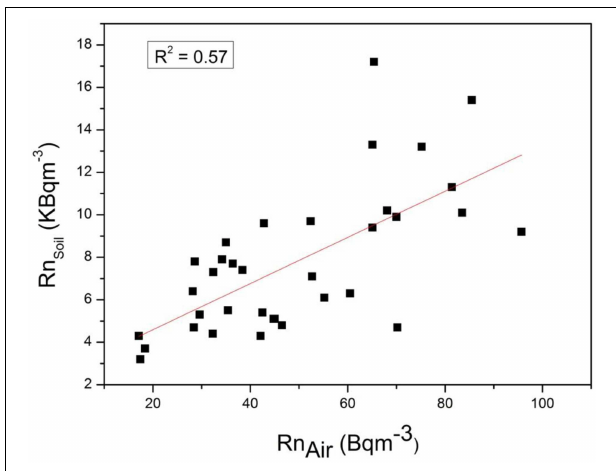
FIGURE 3 | Correlation of radon concentration in air and soil.